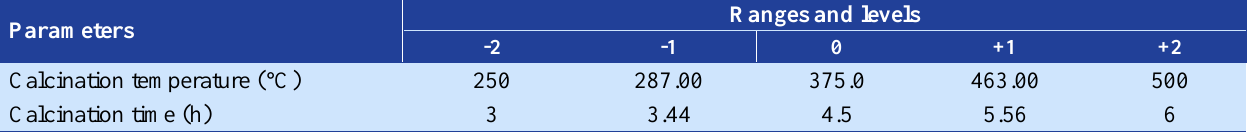
Table 1. Ranges of the experimental parameters Parameters Calcination temperature (°C)